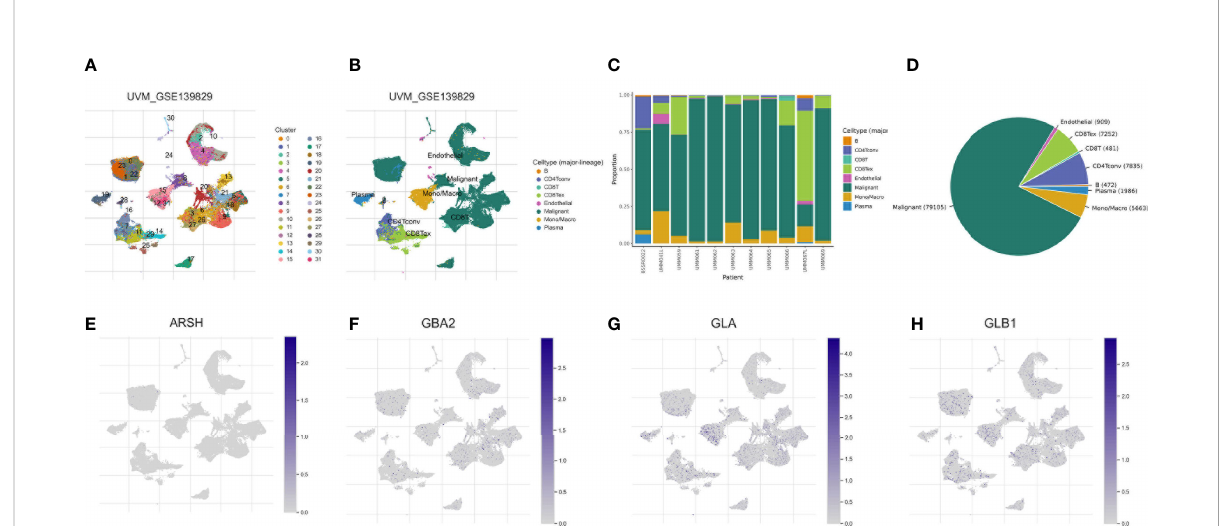
FIGURE 9 Correlation of SMGs with tumor microenvironment. (A – D) Annotation of all cell types in UVM_GSE139829 and the percentage of each cell type. Percentages and expressions of (E) ARSH, (F) GBA2, (G) GLA and (H)